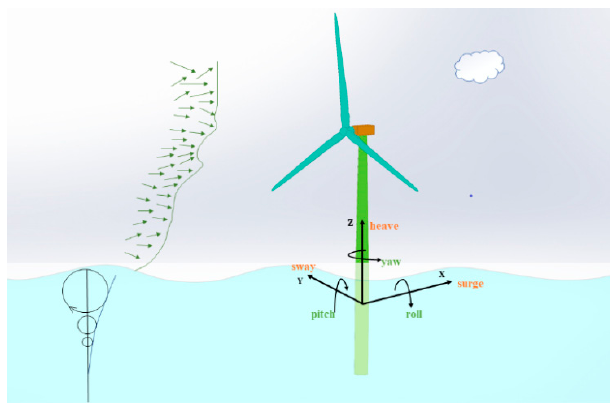
Figure 1. Six DOFs motions for a floating offshore wind turbine.